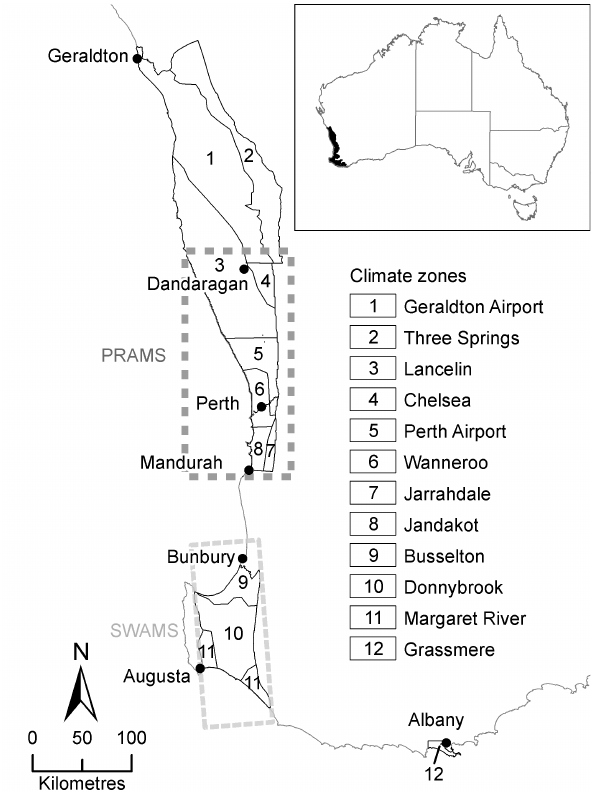
Fig. 1. Location map showing groundwater model regions and cli- mate zones in the south-west of Western